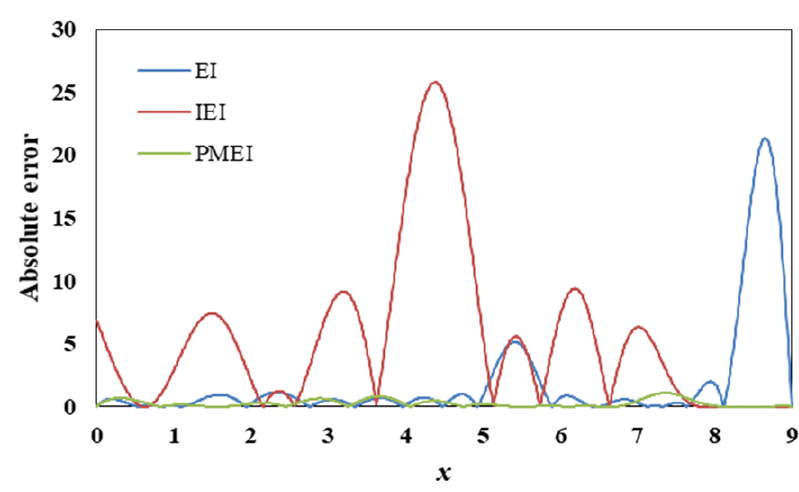
Figure 3. The absolute error of one-dimensional function.